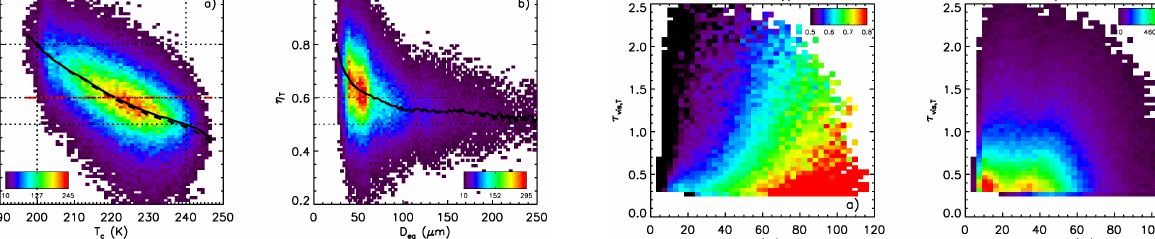
Figure 10. (a) Mean value of the multiple scattering factor η T as a function of visible optical depth ( τ vis , T ) and estimated lateral dis- placement (ld); (b) associated number of samples. Same data set as in Fig.